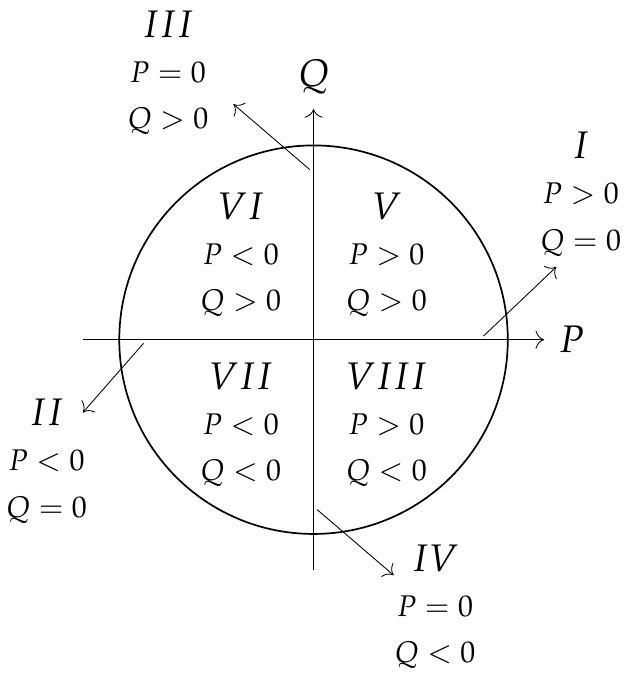
Figure 1. An illustration of the four-quadrant operation and its corresponding 8 modes for bidirec- tional wireless